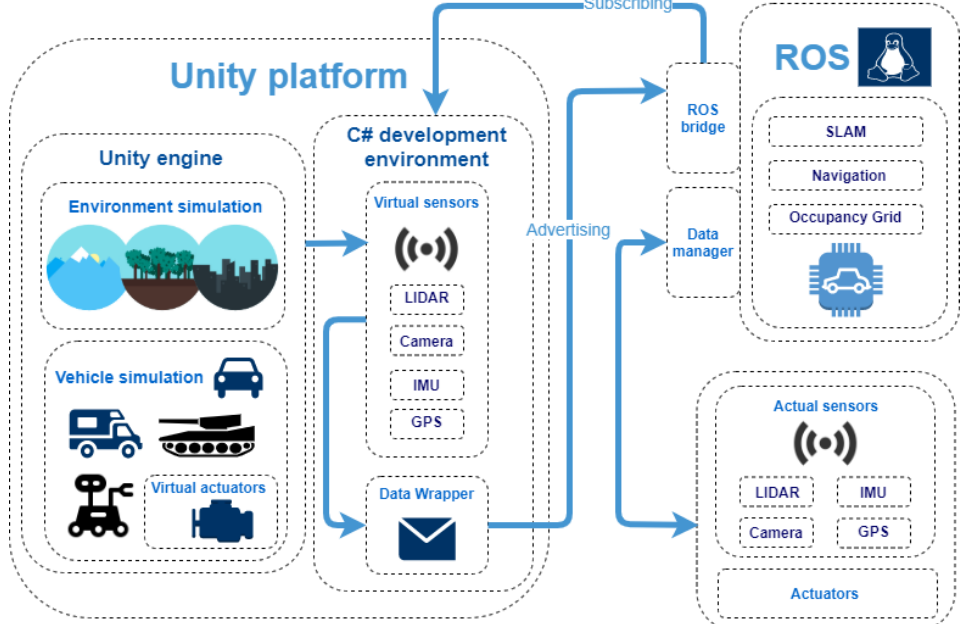
Figure 2. Experimental